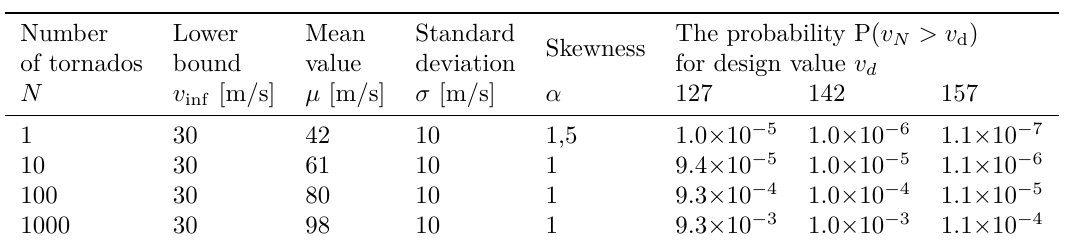
Table 4. Probability P( v N > v d ) of exceedance the design values v d .